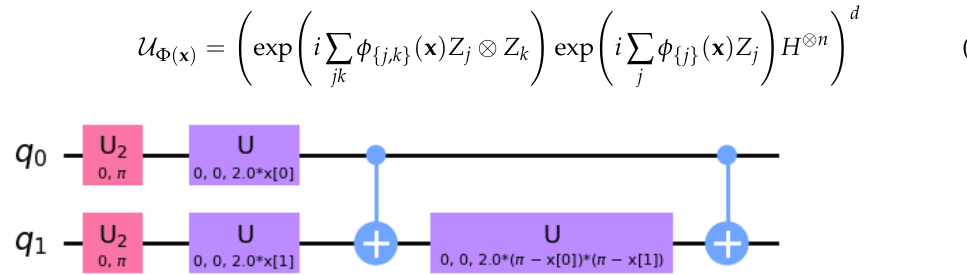
Figure 5. Schematic diagram of the analog circuit of